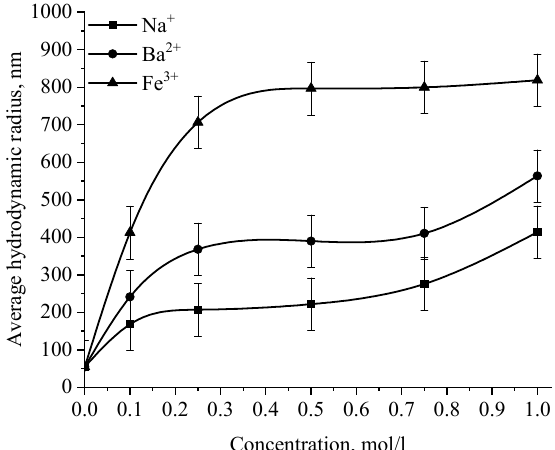
Figure 16. Dependence of the average hydrodynamic radius of Se NPs in negative sol on the con- centration of various cations.